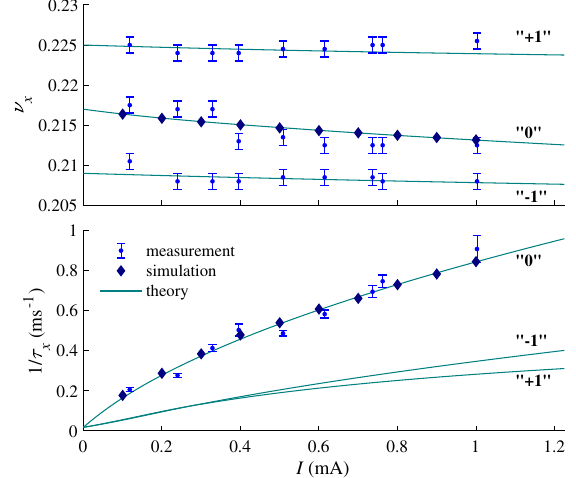
FIG. 5. Frequencies (top) and damping/growth rates (bottom) of horizontal head-tail modes; ξ